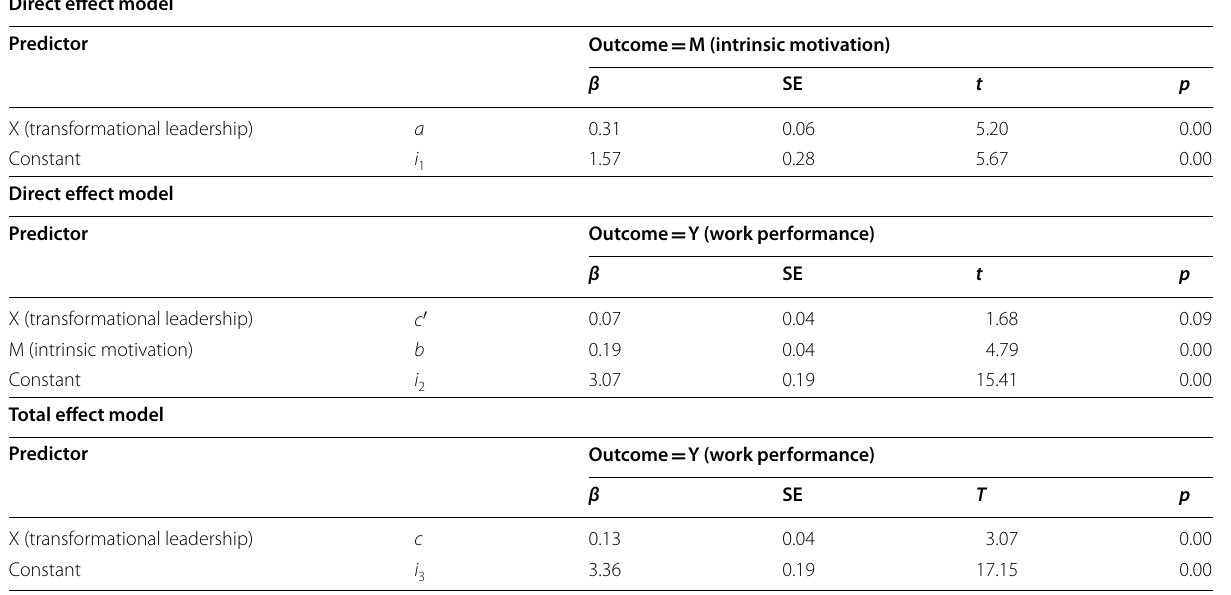
N 308; SE standard error; bootstrap sample size = =